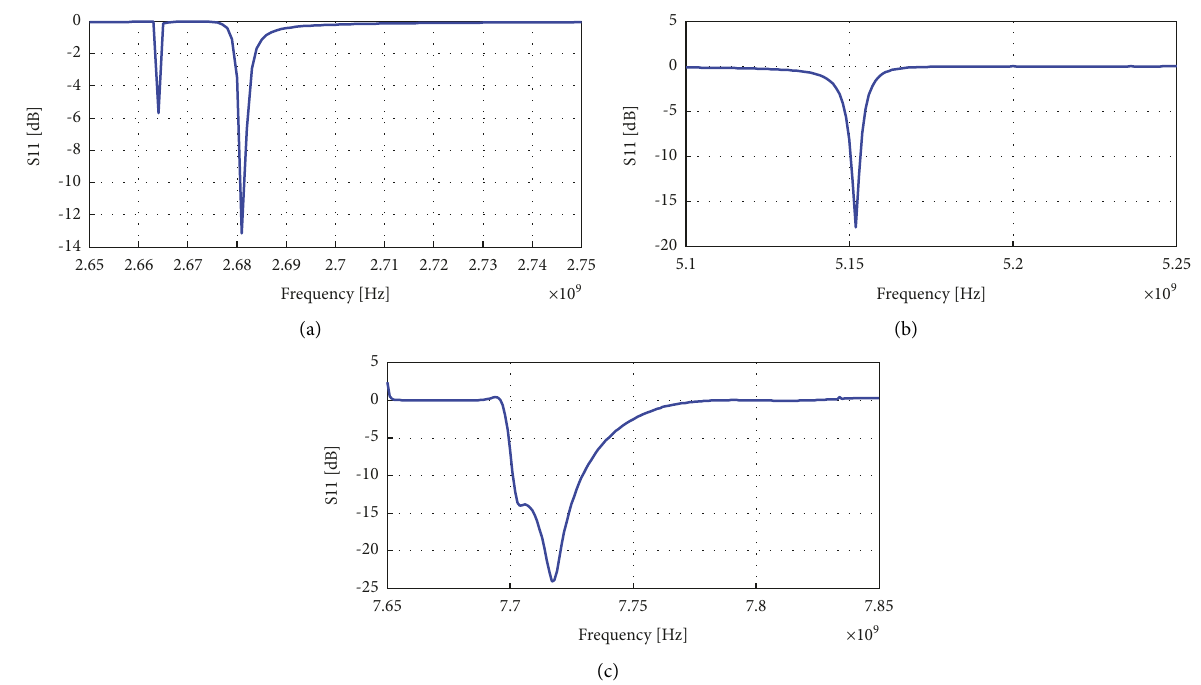
� − 13dB). (b) Return loss of the proposed antenna ( f � 5.15GHz and 11